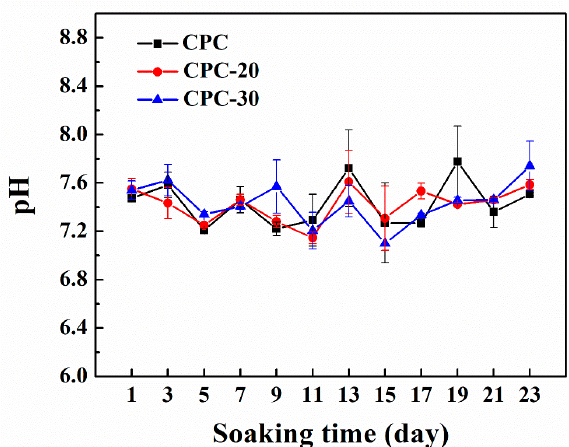
Figure 9. Change in pH value of SBF solution during PLGA-PEG-PLGA / CPCs degradation studies (n = 4).